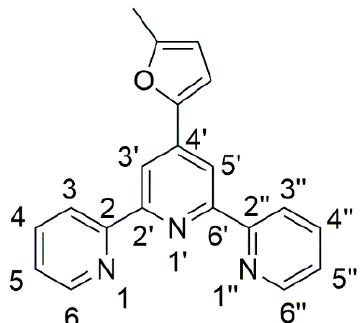
Figure 1. Chemical structure and atom-numbering of 4 ′ -(5-methylfuran-2-yl)-2,2 ′ :6 ′ ,2 ″ -terpyridine ( 1 ).